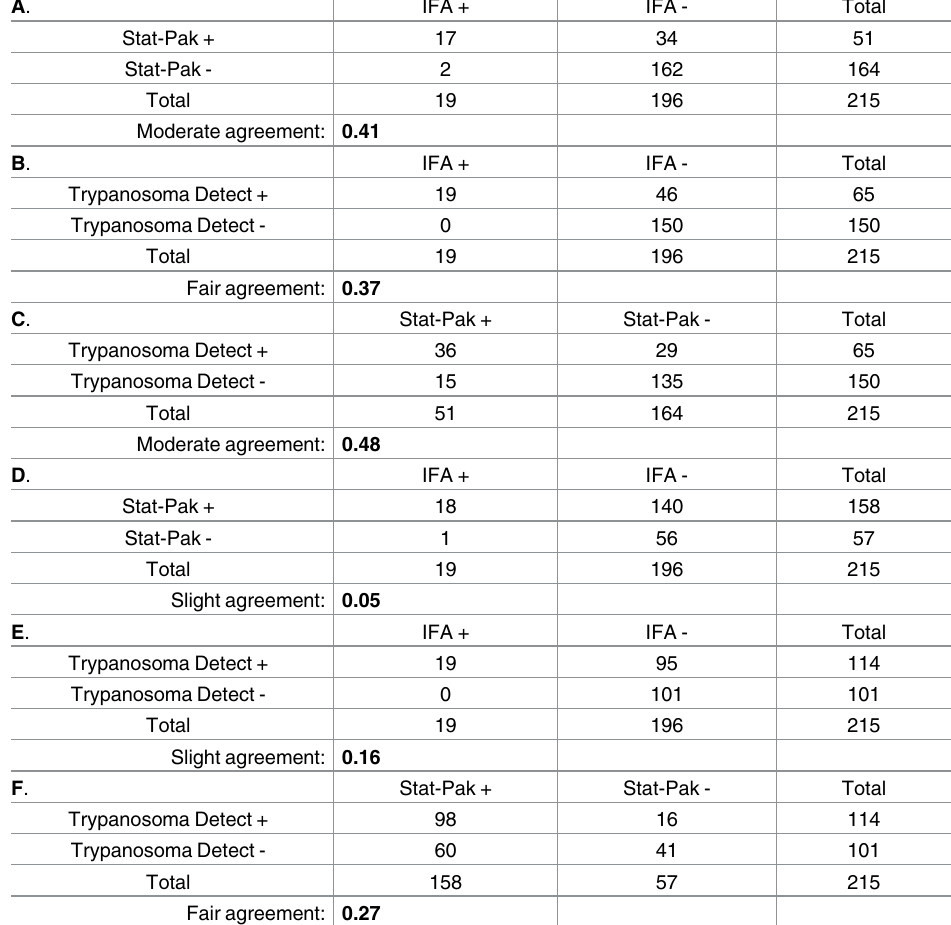
Table 5. Kappa index comparing three serological assays;Chagas Stat-Pak rapid immunochromato- graphic test (ChemBio, NY), indirect fluorescent antibody (IFA) test and Trypanosoma Detect (InBios, International, Inc., Seattle, WA). Panels A-C represent KappaIndex when interpretingimmunochromato- graphic test results using the conservative method A (includingvery faint serologicalbandsas negative); Pan- els D-F represent KappaIndex when interpretingimmunochromatographic test results using the inclusive method B (includingvery faint serological bandsas positive). A . IFA + IFA - Stat-Pak +